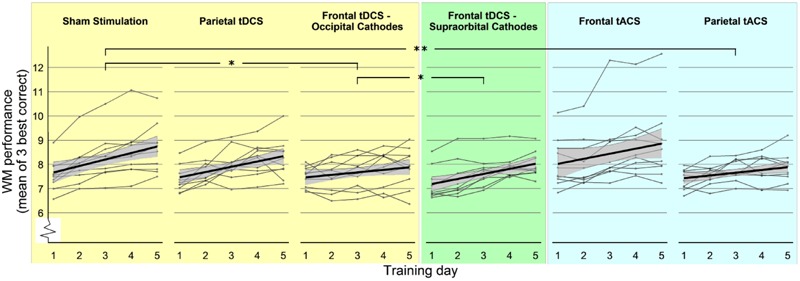
WM performance over the five training days. Participants’ performance in WM training throughout the training period, experimental groups separated. Each thin line represents one participant, showing daily mean of the three highest-level correct items as dots. Thick lines represent the regression line of the group, surrounded by the 95% confidence interval (gray area). Stars (∗p < 0.05; ∗∗p < 0.01) refer to significant effects of interaction between Group and Day in mixed linear models comparing two groups (see Results).